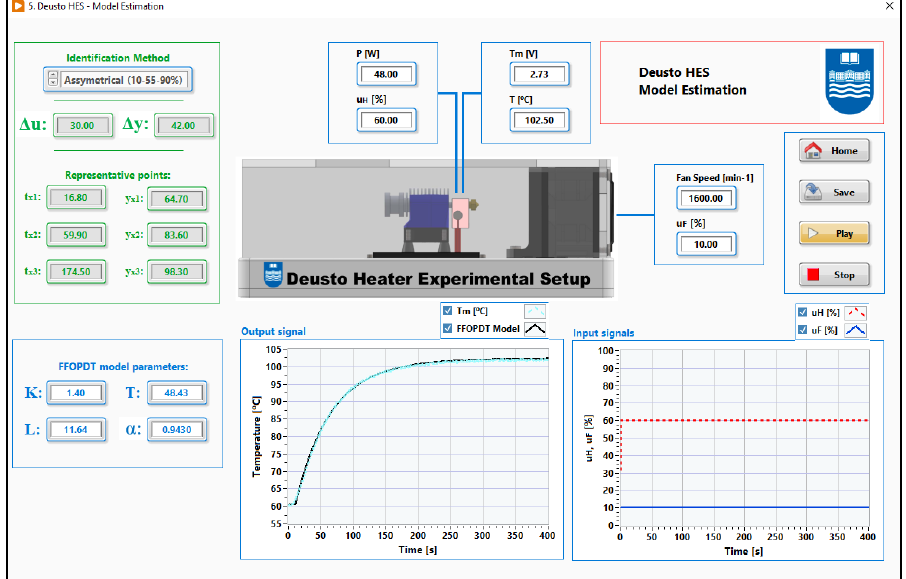
Figure 32. Front panel of the LabVIEW-based application for implementing the fractional-order identification algorithm proposed in this paper. This figure illustrates the different features available in this application.